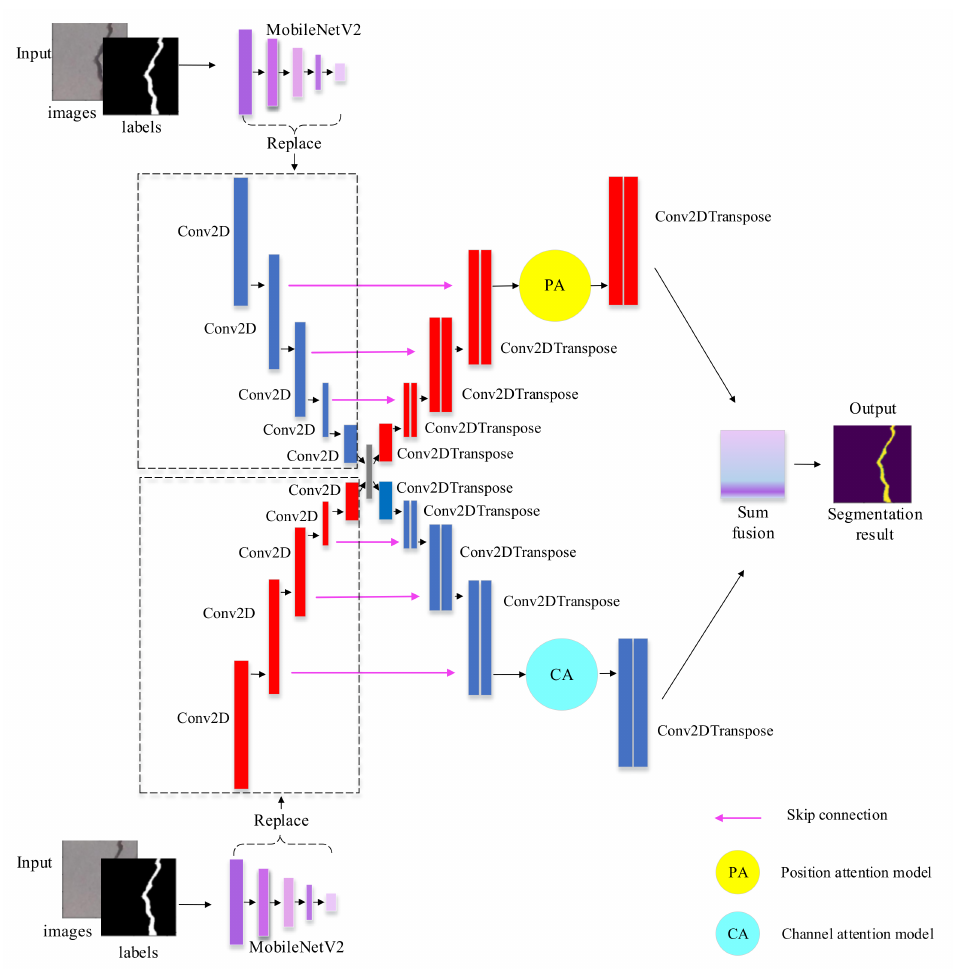
Figure 1. Proposed MA-Xnet